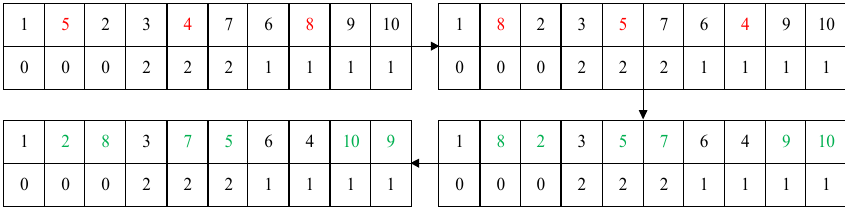
Figure 8. Chromosome variation diagram.